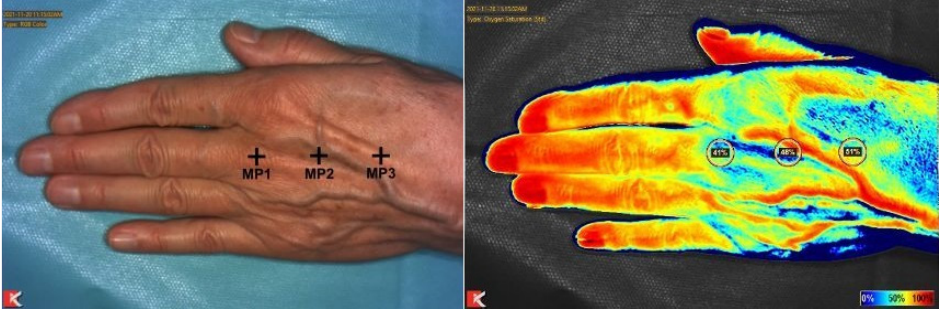
Figure 1. Study design and measuring timepoints (t0–t4).